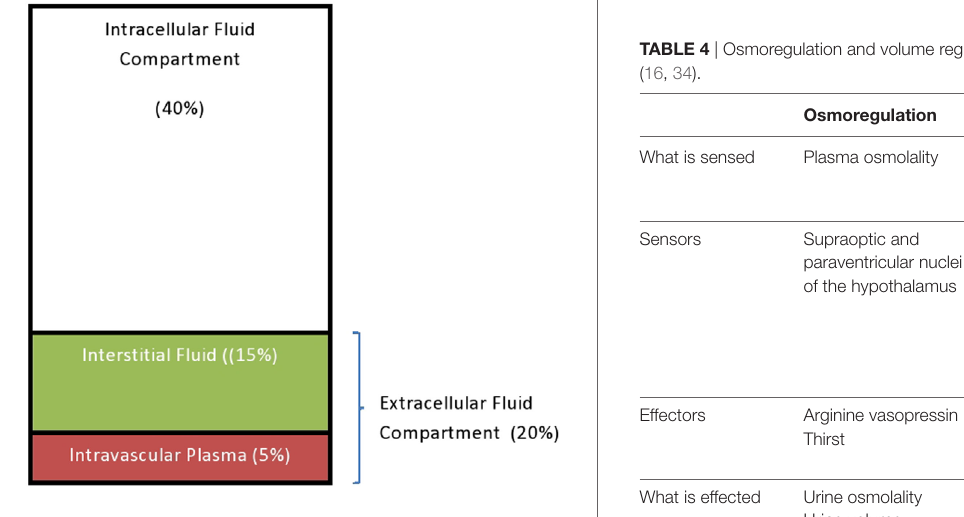
FiGURe 1 | The total water distribution in a 12-month-old child.